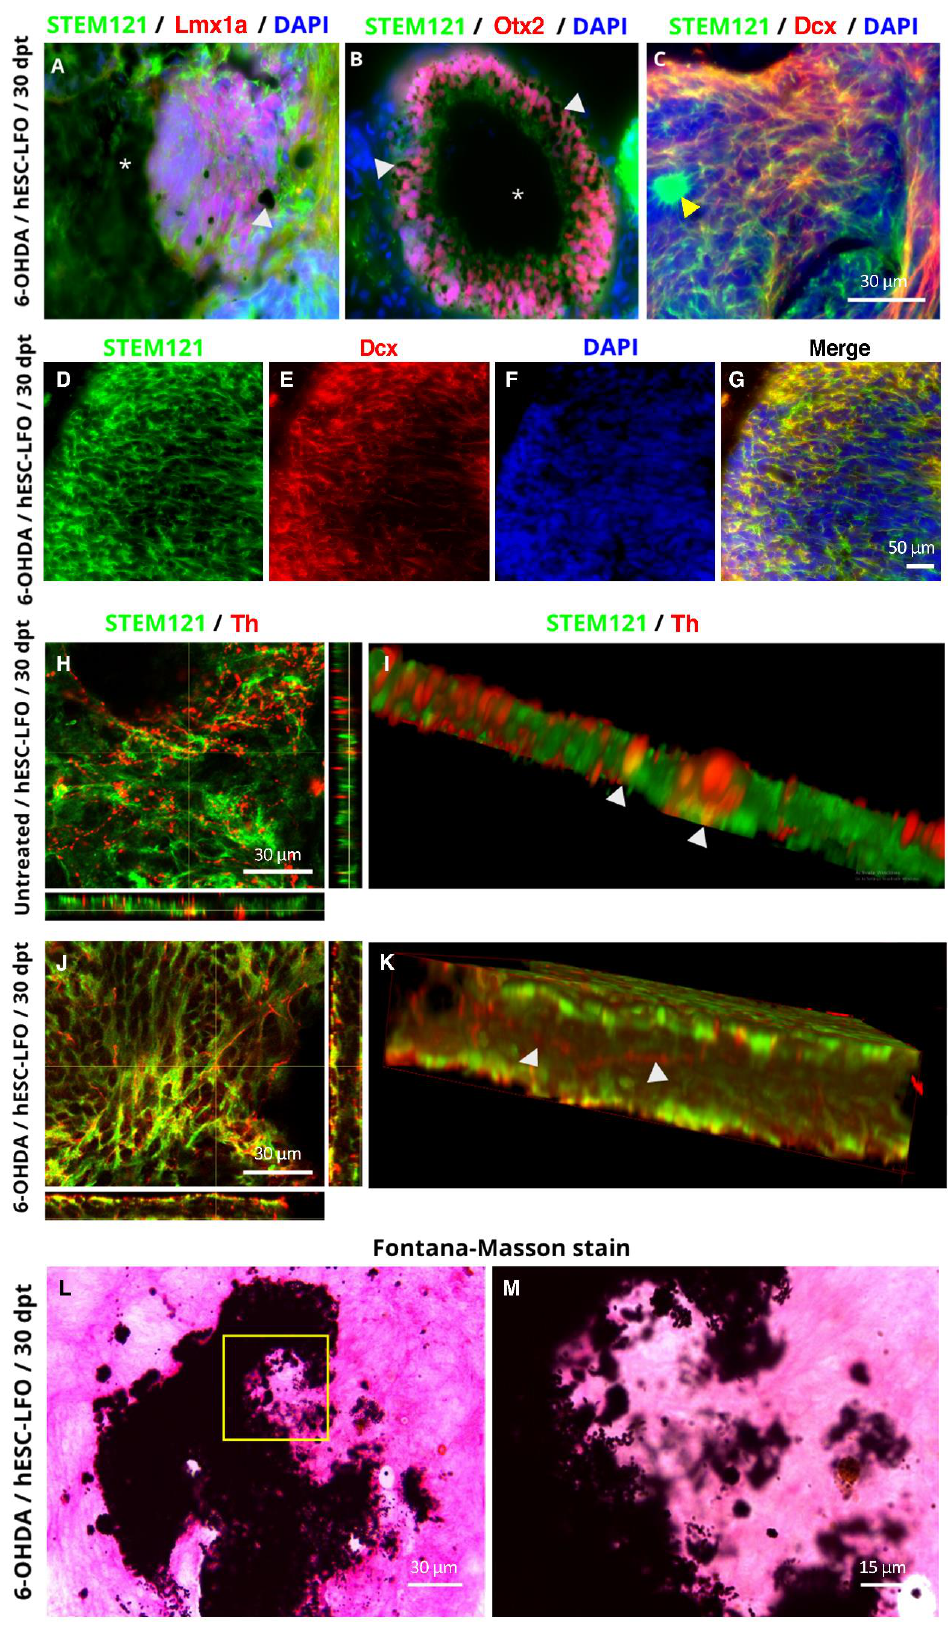
Figure 6. hESC-LFO EBCs grafts express tyrosine hydroxylase at 30 days post-transplantation in untreated and 6-hydroxydopamine-lesioned rats. ( A – C ) Representative images of the